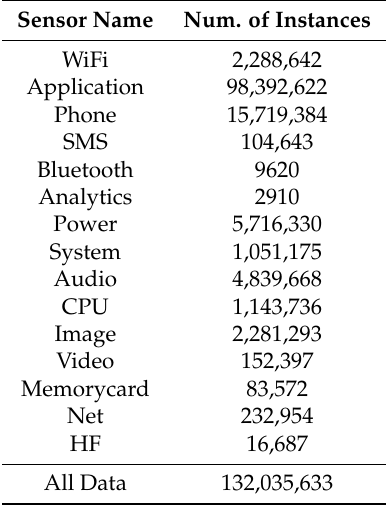
Table 2. Numbers and types of sensors for 35 random users’ data from Device Analyzer